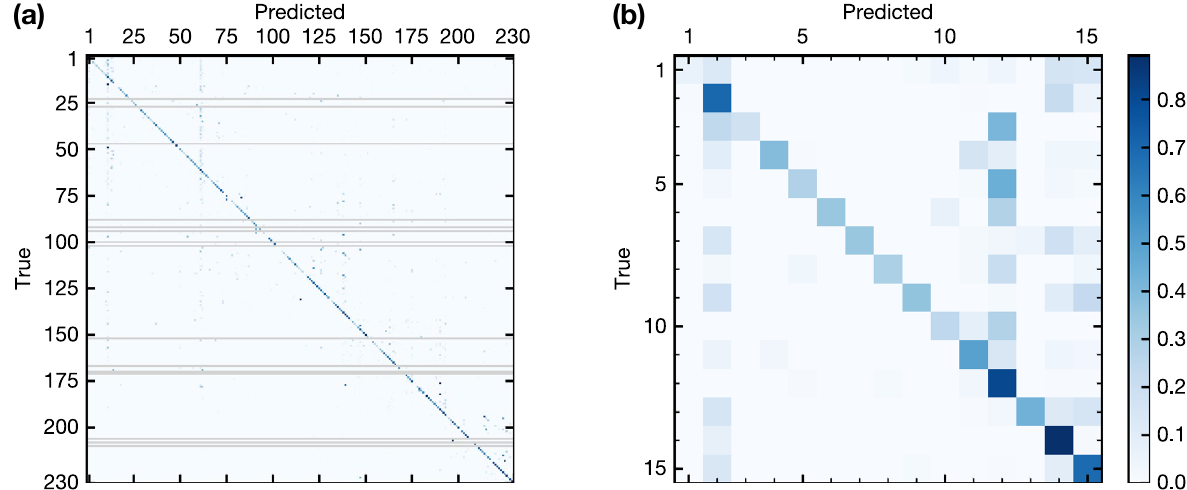
Figure 4. Normalised confusion matrix for space group classification. Normalisation is done in the horizontal direction. Tick labels represent space group numbers. ( a ) The overall confusion matrix. Some space groups lacked in the test data are shown as grey horizontal lines. ( b ) The confusion matrix of triclinic and monoclinic crystal systems [the upper left corner of ( a